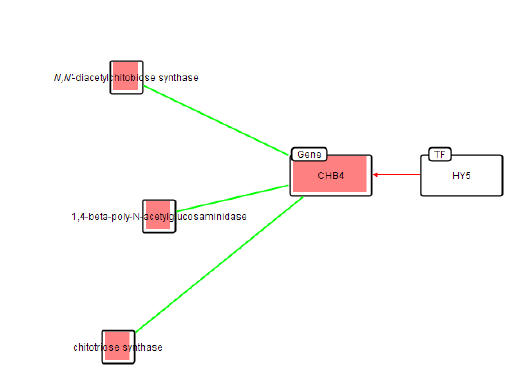
Figure 7: An alternative extracted view, showing the full pathway, created using a user selection of an enzyme in the network shown in Fig.